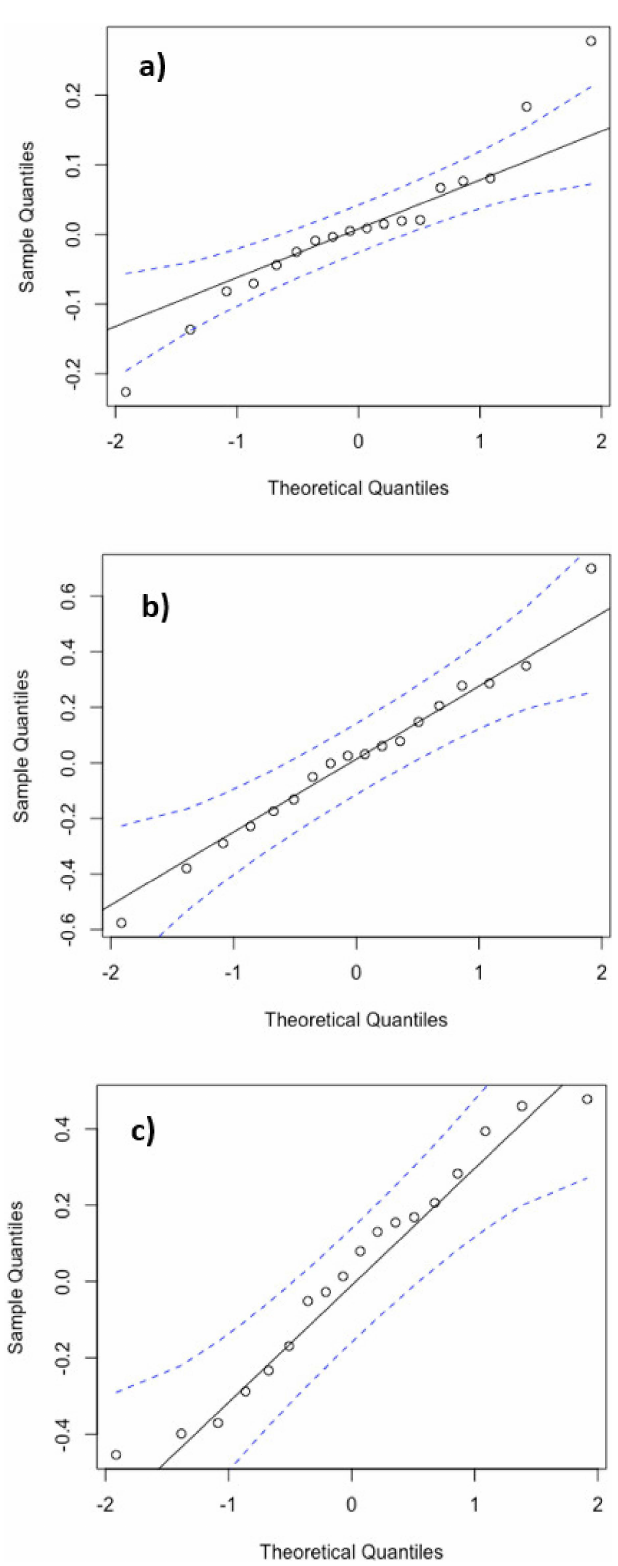
Figure A6. Residual normal probability plot for the glycerol dehydration and EG formation kinetic parameters estimation: ( a ) 180 ◦ C, ( b ) 200 ◦ C, ( c ) 220 ◦